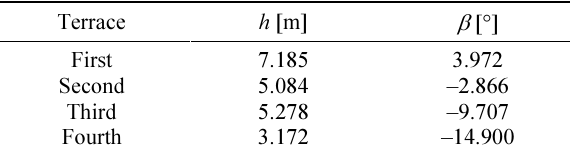
Table 7. Constant variables for SchRs